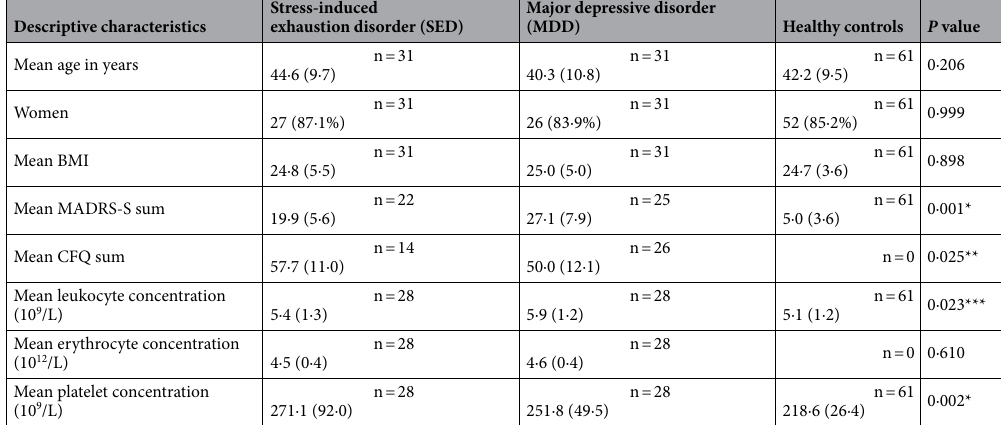
Table 2. Descriptive characteristics of patients with stress-induced exhaustion disorder (n = 31), patients with major depressive disorder (n = 31), and healthy controls (n = 61). Data are mean (SD) or n (%). *Significant at a 0.05 level between SED and healthy controls and between MDD and healthy controls. **Significant at a 0.05 level between SED and MDD. ***Significant at a 0.05 level between MDD and healthy